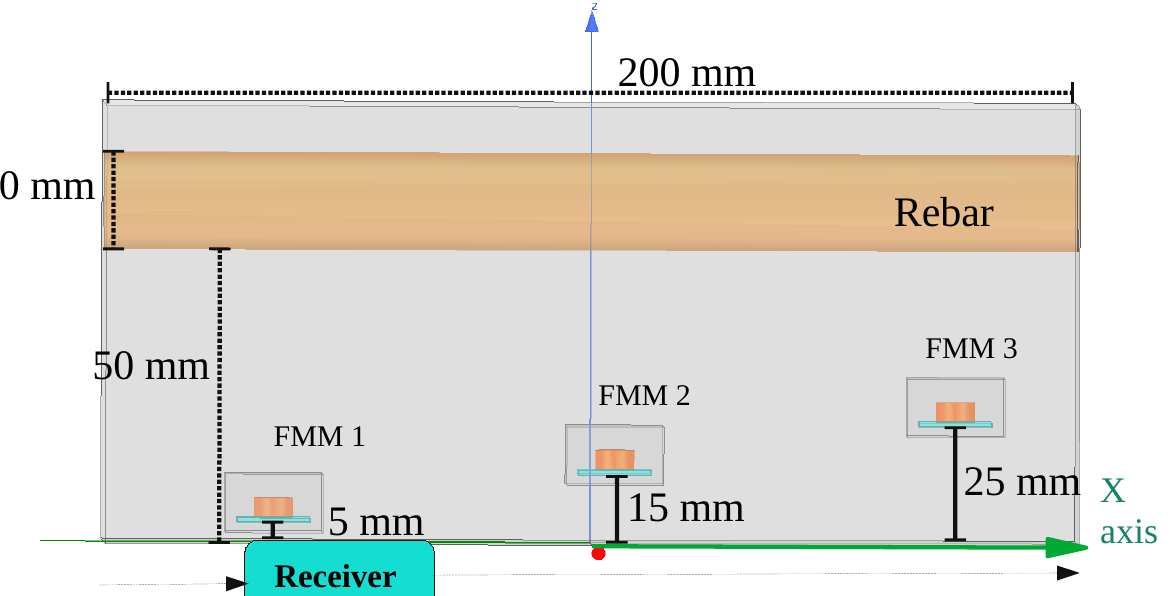
Figure 13. Configuration 3: three FMM tools embedded in cover concrete with rebar, featuring variable thickness and a constant reactive-part surface area equal to 25 mm × 25